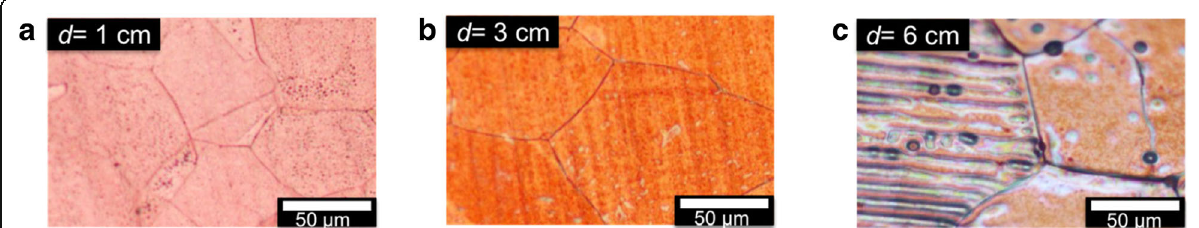
Fig. 3 The optical images of the graphene on Cu substrate grown at temperature 1000 °C with the distance between a nozzle and a substrate of a 1 cm, b 3 cm, and c 6 cm growth